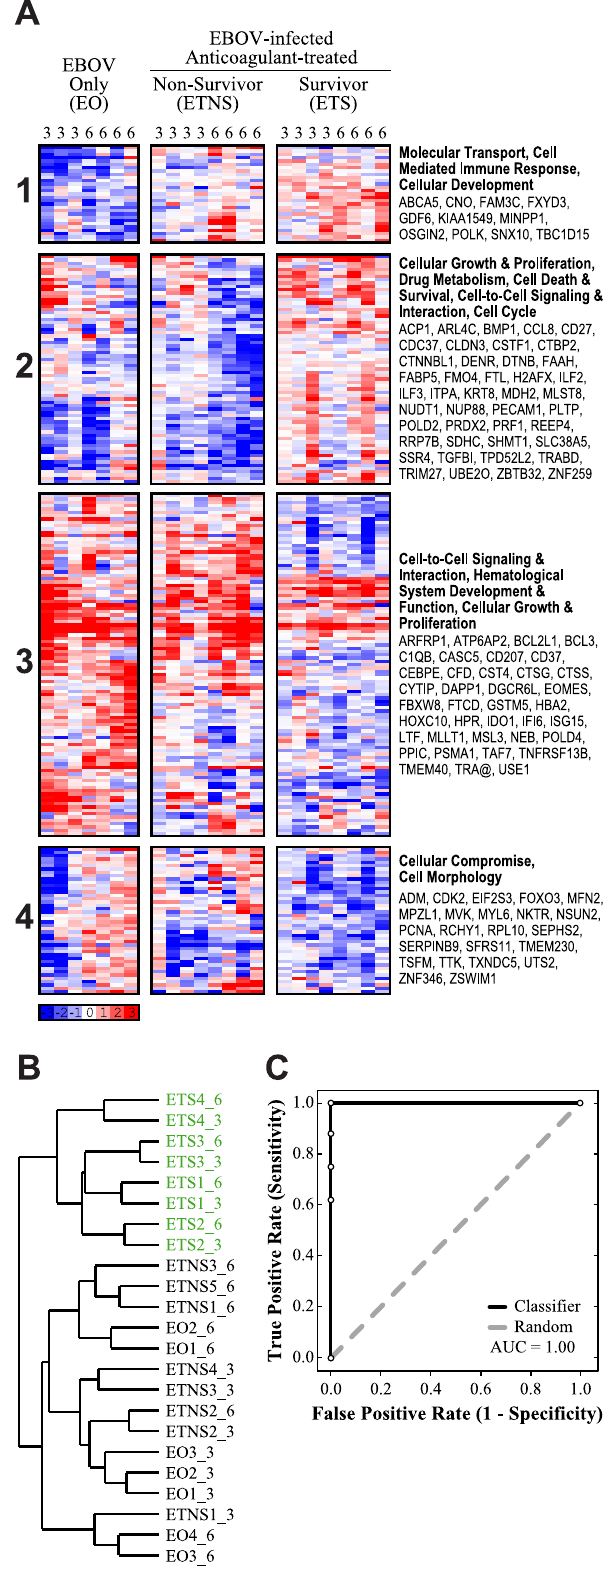
Figure 2. Survival following anticoagulant treatment is asso- ciated with a broad transcriptional profile. ( A ) A heatmap depicting the gene expression values of 245 probes (238 genes)